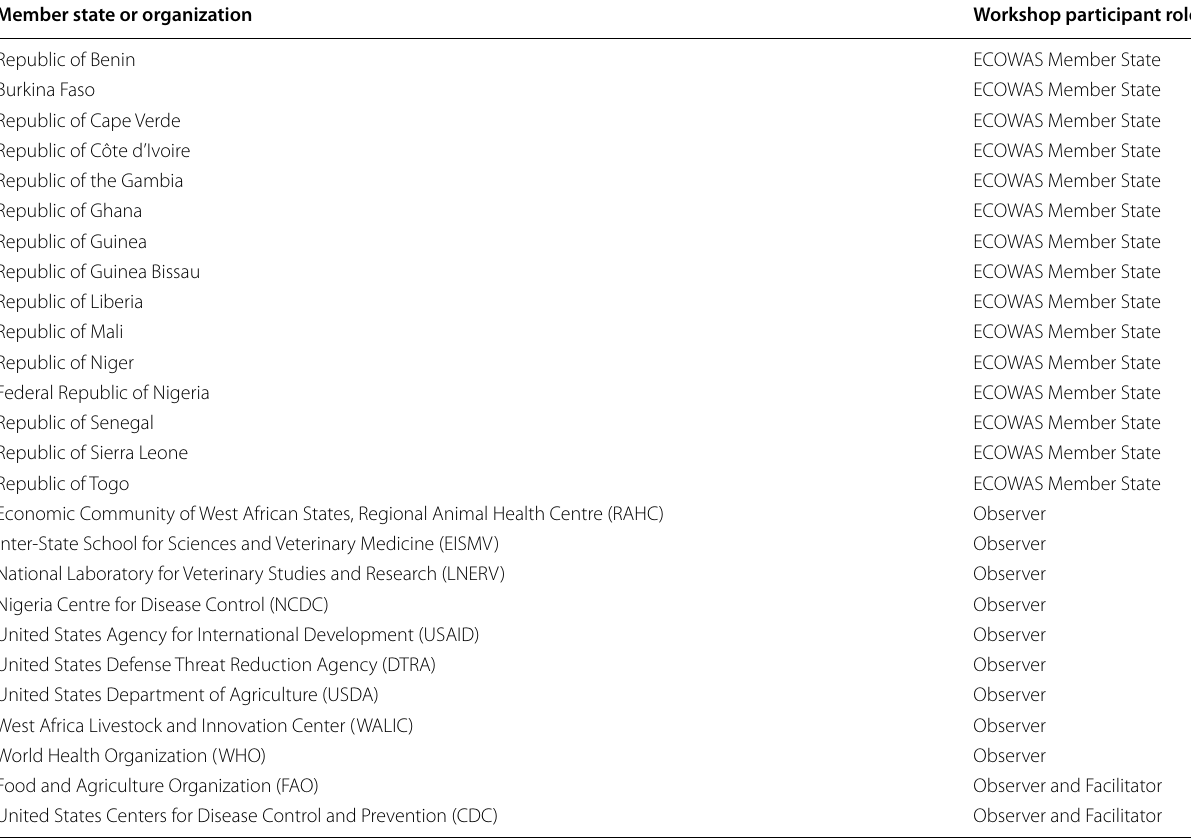
Table 1 Participating organizations and their role for the ECOWAS OHZDP Workshop Member state or